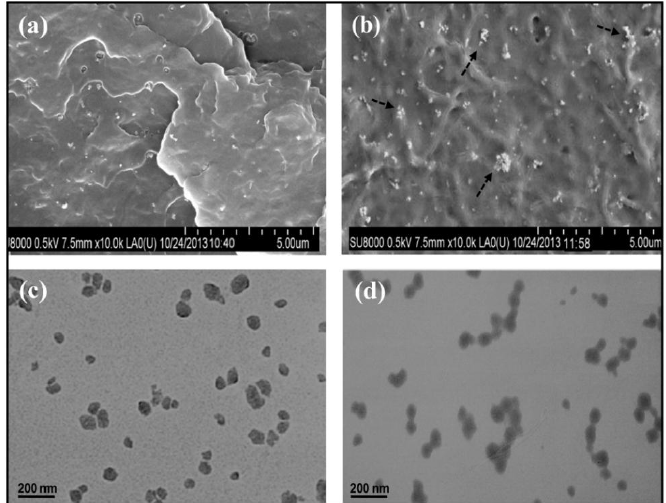
Figure 4. Scanning electron micrographs from fractured surfaces of PHBV/ZnO nanocomposites with ( a ) 1% w / w and ( b ) 8% w / w ZnO loading. The arrows in b point out small nanoparticle aggregates. Transmission electron micrographs of PHBV/ZnO nanocomposites with ( c ) 4% w / w and ( d ) 8% w / w ZnO content. Reproduced with permission from Ref.